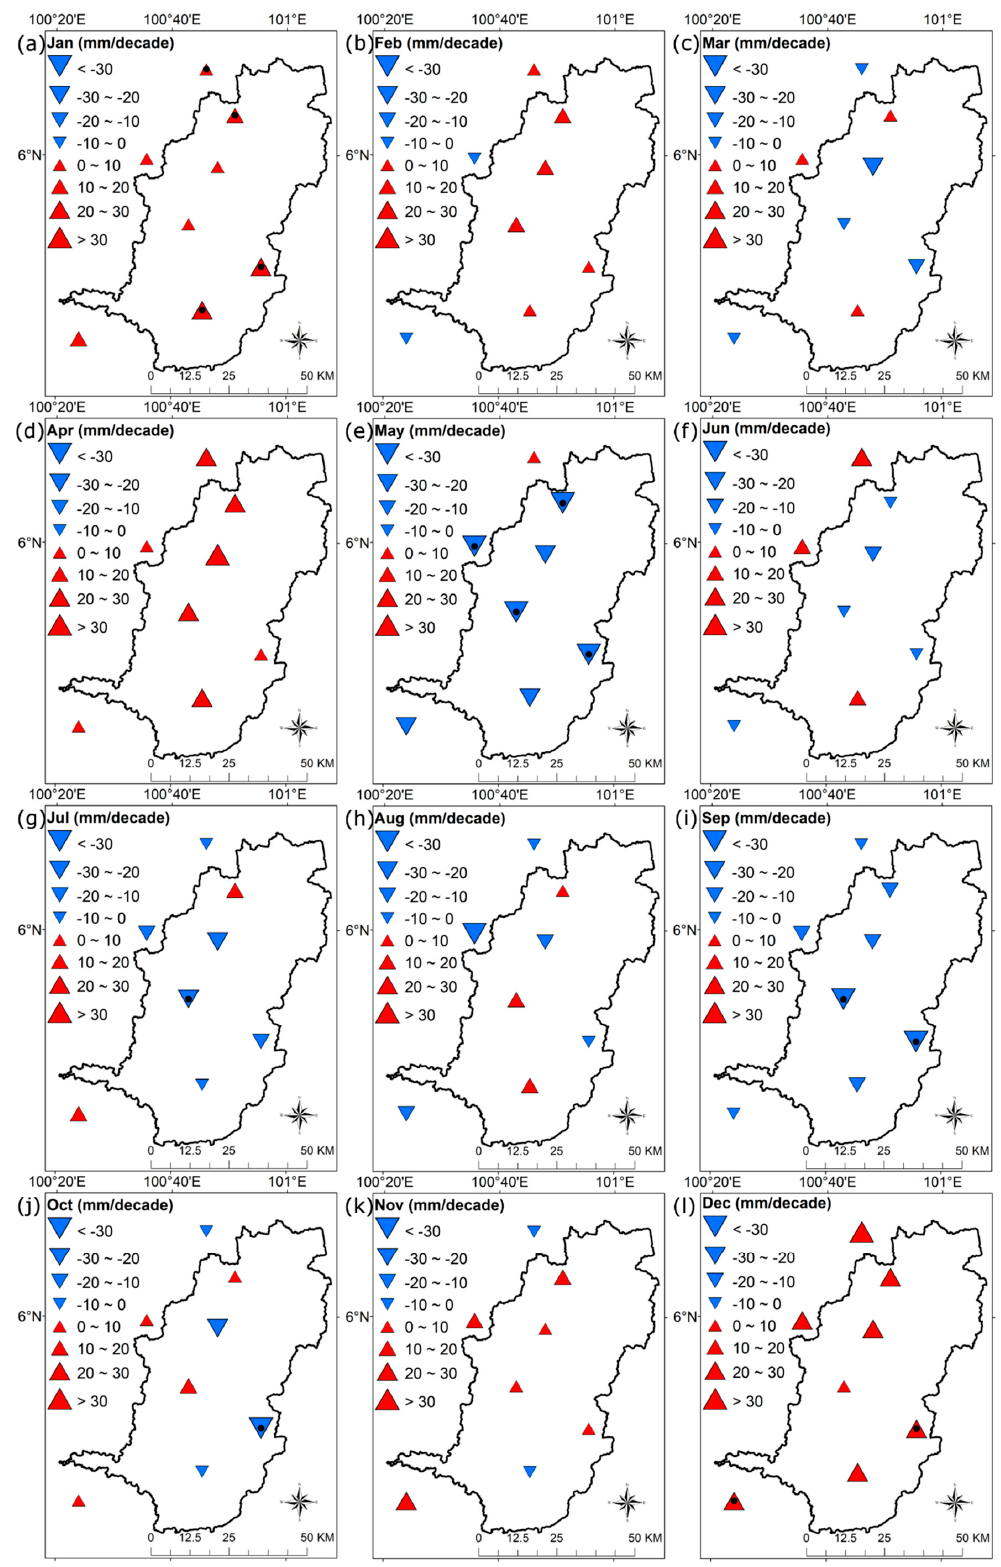
Figure 3. Spatial changes of monthly precipitation over the Muda River Basin from 1985 to 2015. Black dots indicate significant trend at a 95% significance level.